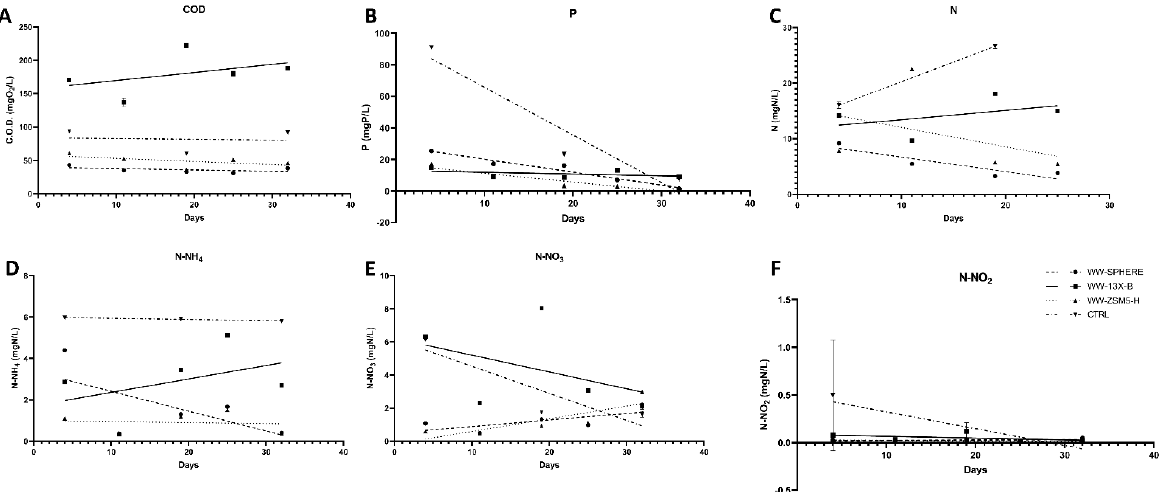
Figure 6. Effect of WW-SPHERE, WW-13X-B and WW-ZSM5-H on critical physicochemical param- eters of WWT comparing with control reactor. ( A ) COD, ( B ) P, ( C ) N, ( D ) N-NH 4 , ( E ) N-NO 3 , ( F ) N-NO 2 .